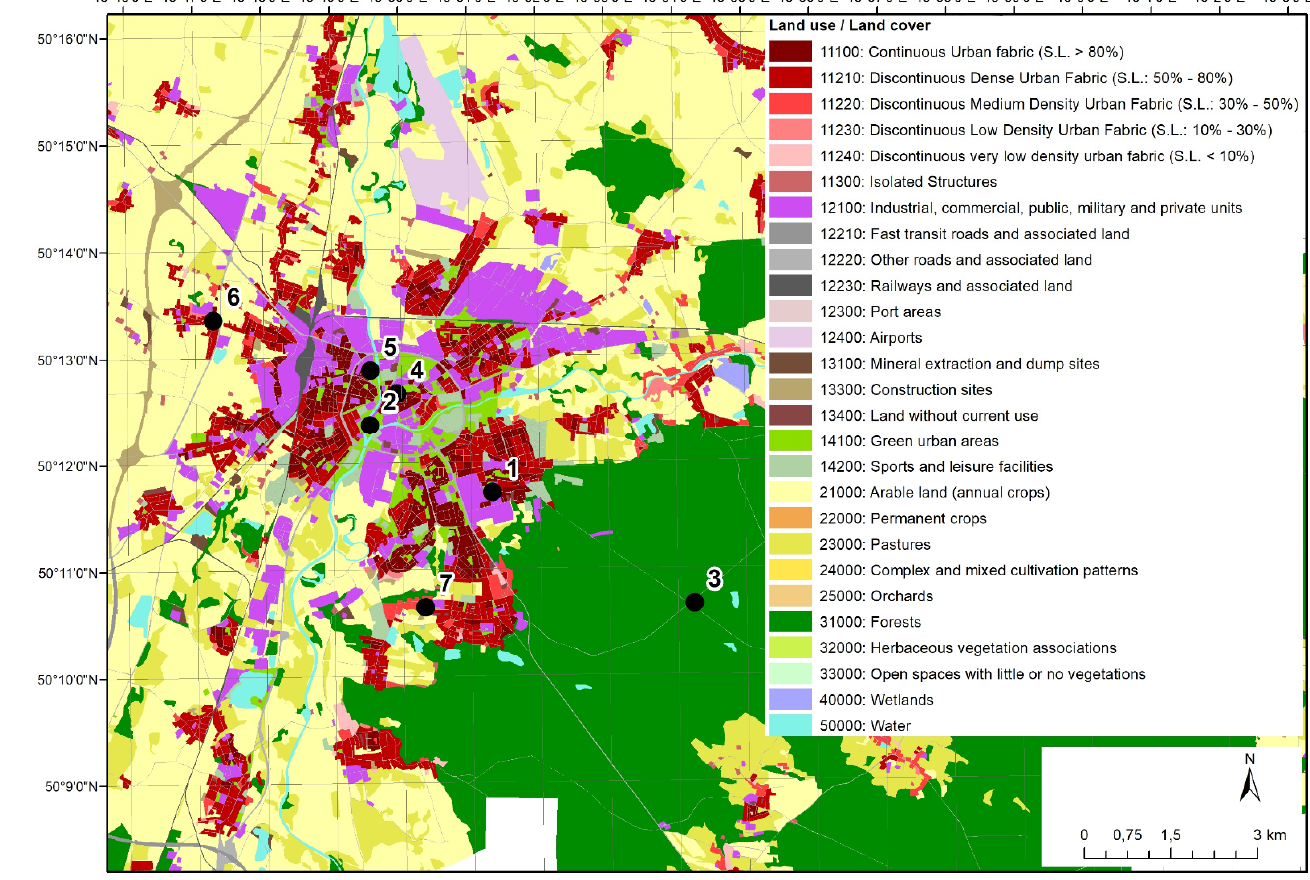
Figure 3. The land use/land cover of study area with marked AT measurement network–Section 2.3B (points numbered 1–7). Data from [38].